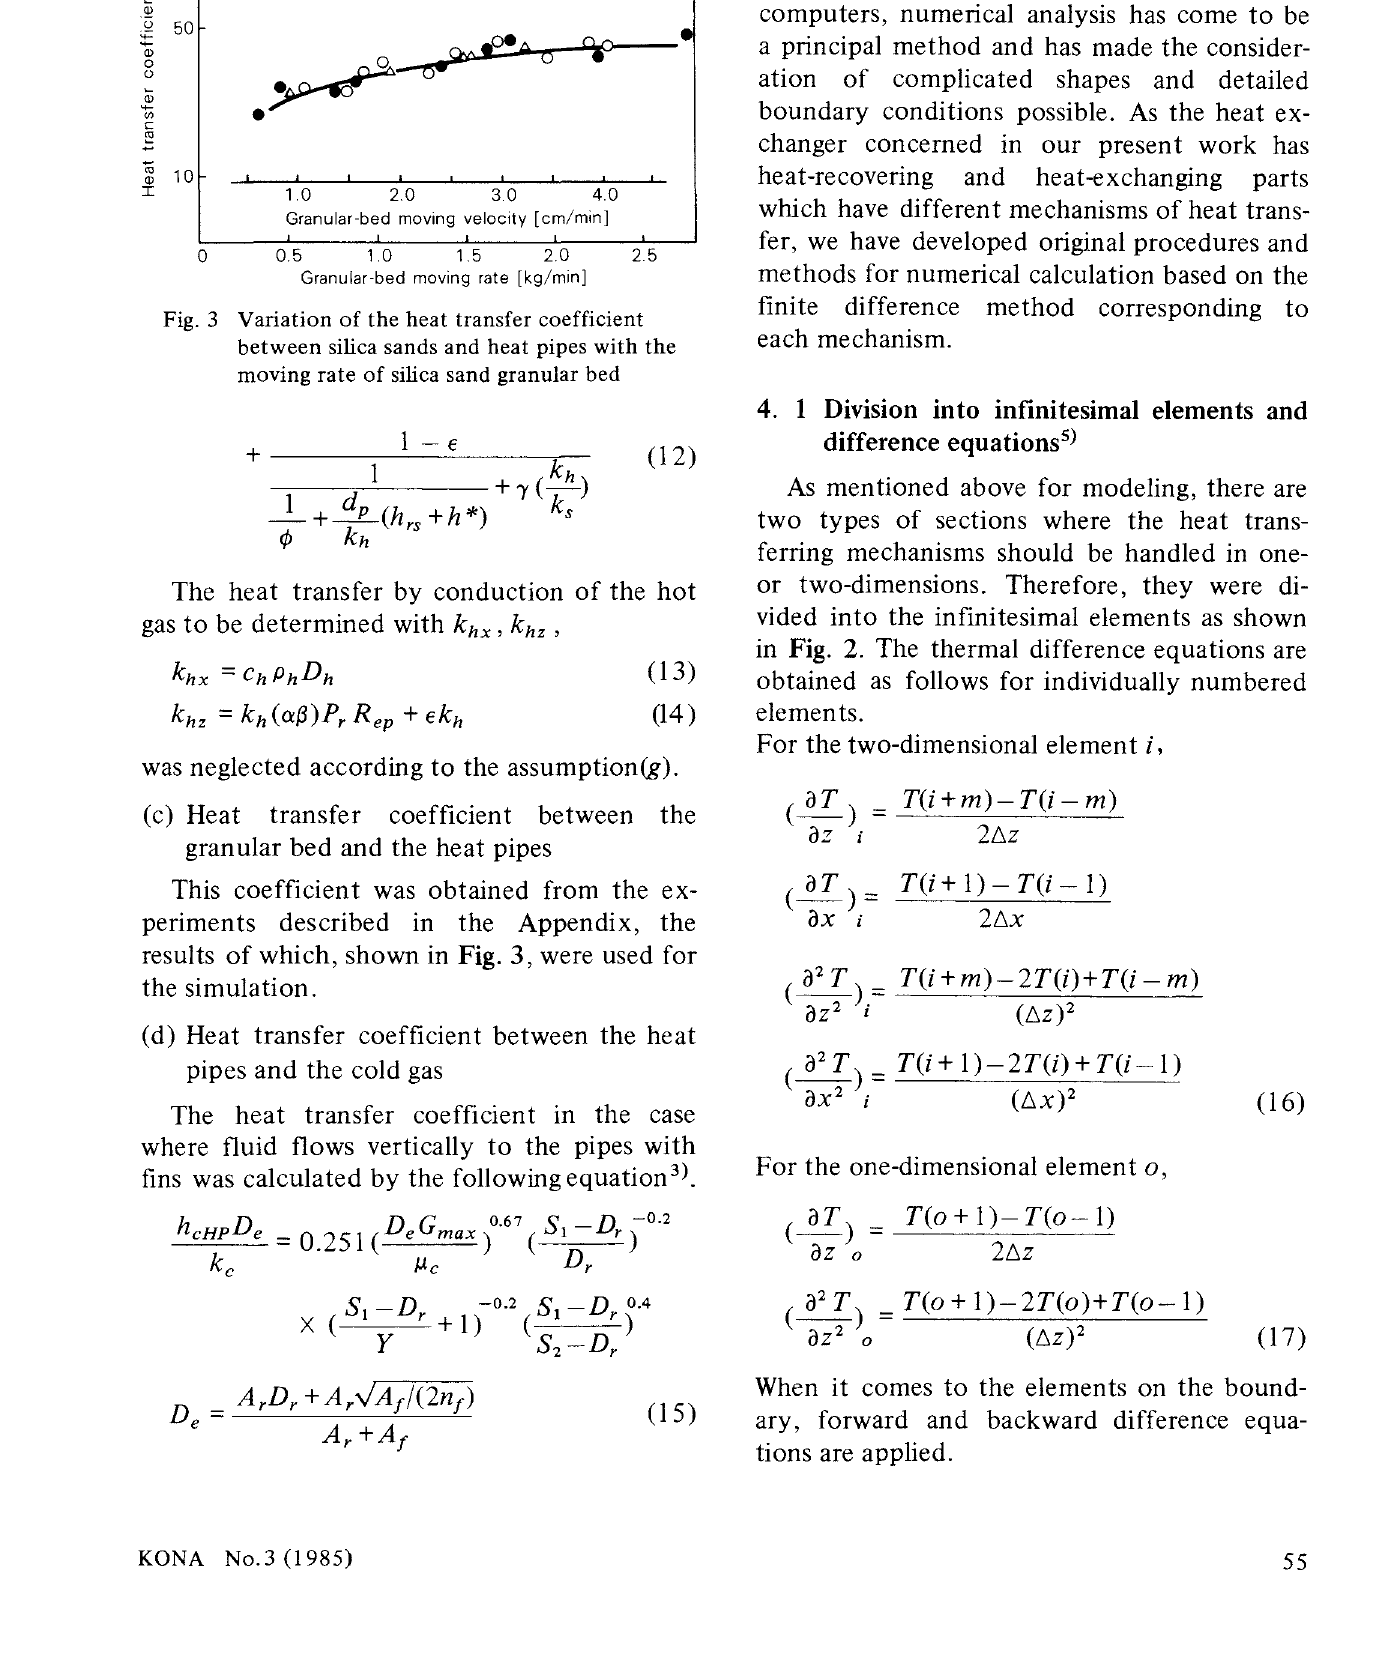
Fig. 3 Variation of the heat transfer coefficient between silica sands and heat pipes with the moving rate of silica sand granular